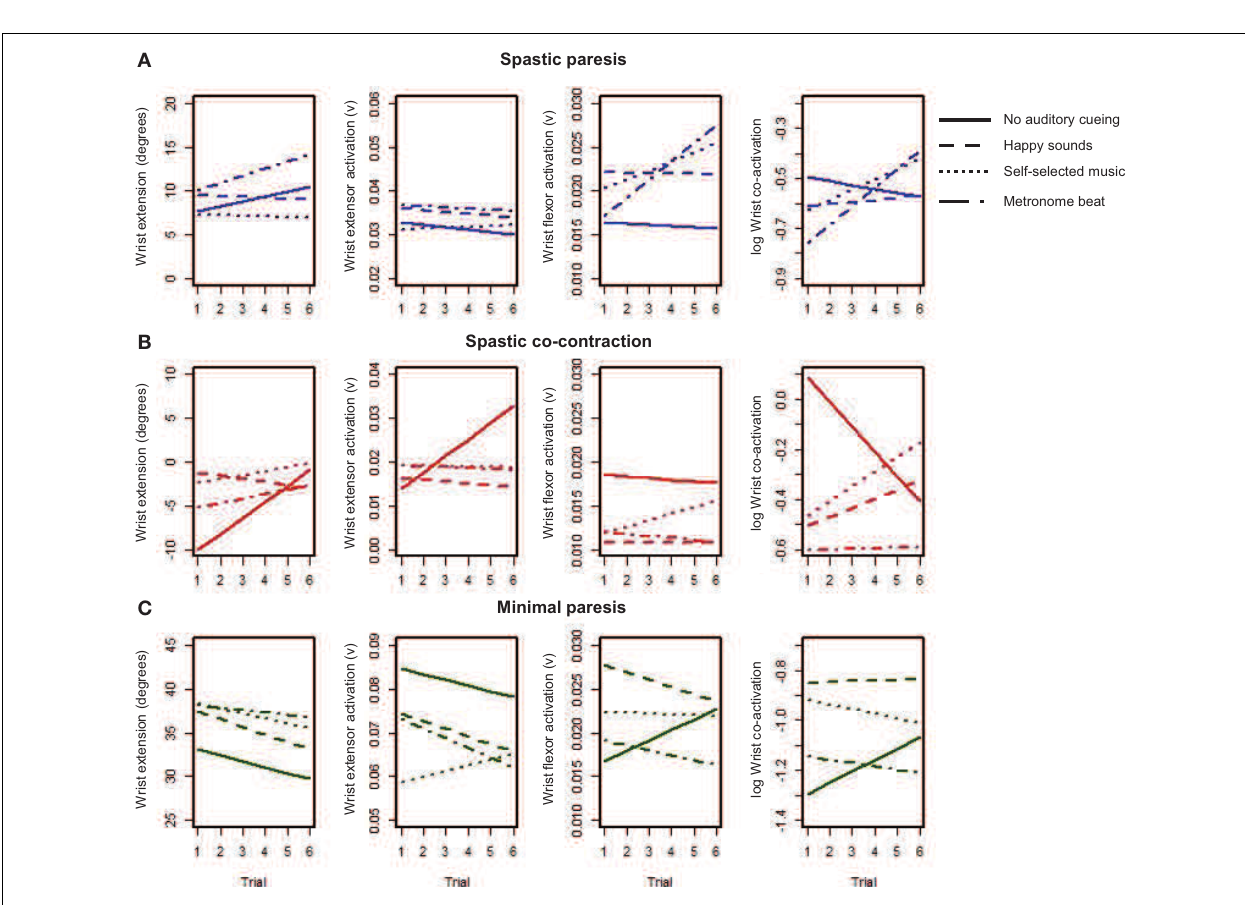
FIGURE 5 |Trendlines of wrist extension performance variables over six repeated trials with the paretic hand under each condition for the three groups: (A) spastic paresis (blue); (B) spastic co-contraction (red); (C) minimal paresis (green) .The four conditions are represented by the different patterned